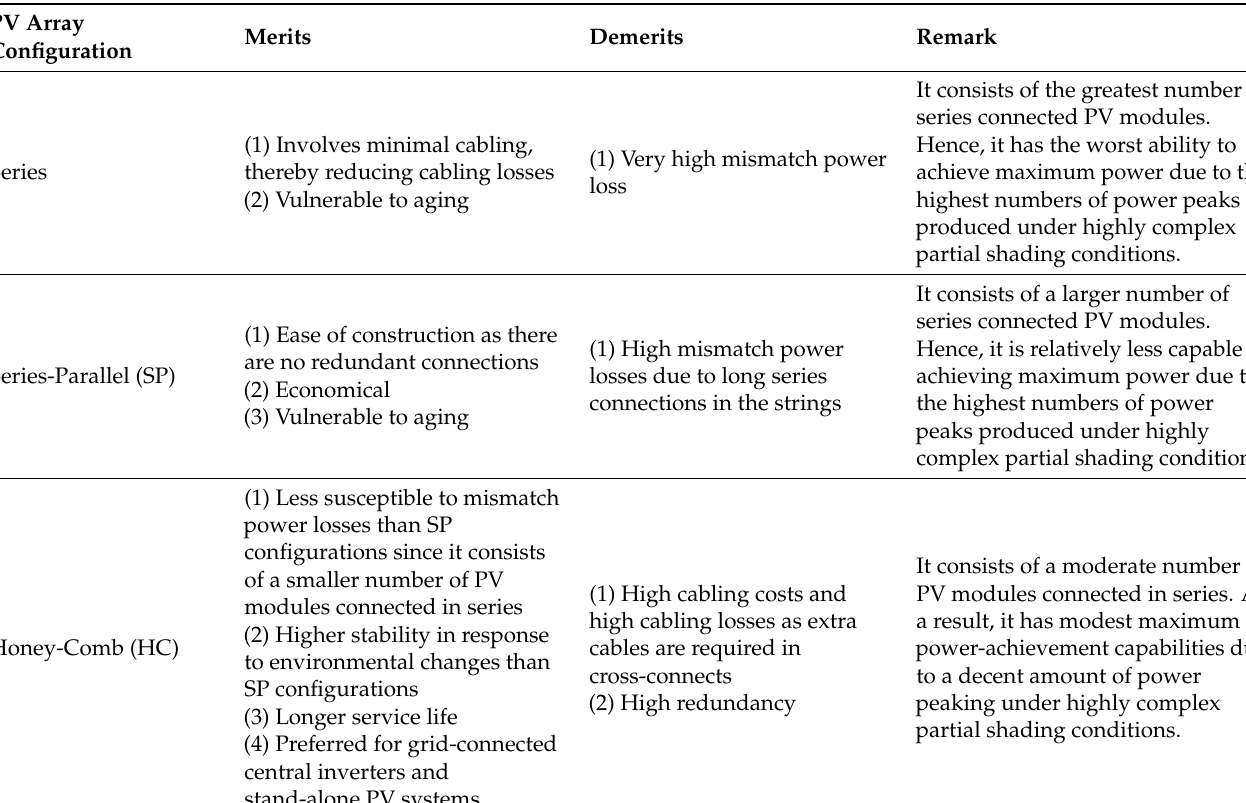
Figure 11. PV array configuration models: ( a ) series, ( b ) series-parallel (SP), ( c ) honeycomb (HC), ( d ) bridge-link (BL), ( e ) triple-tied (TT). Table 8. Overview of PV array configurations with their pros and cons